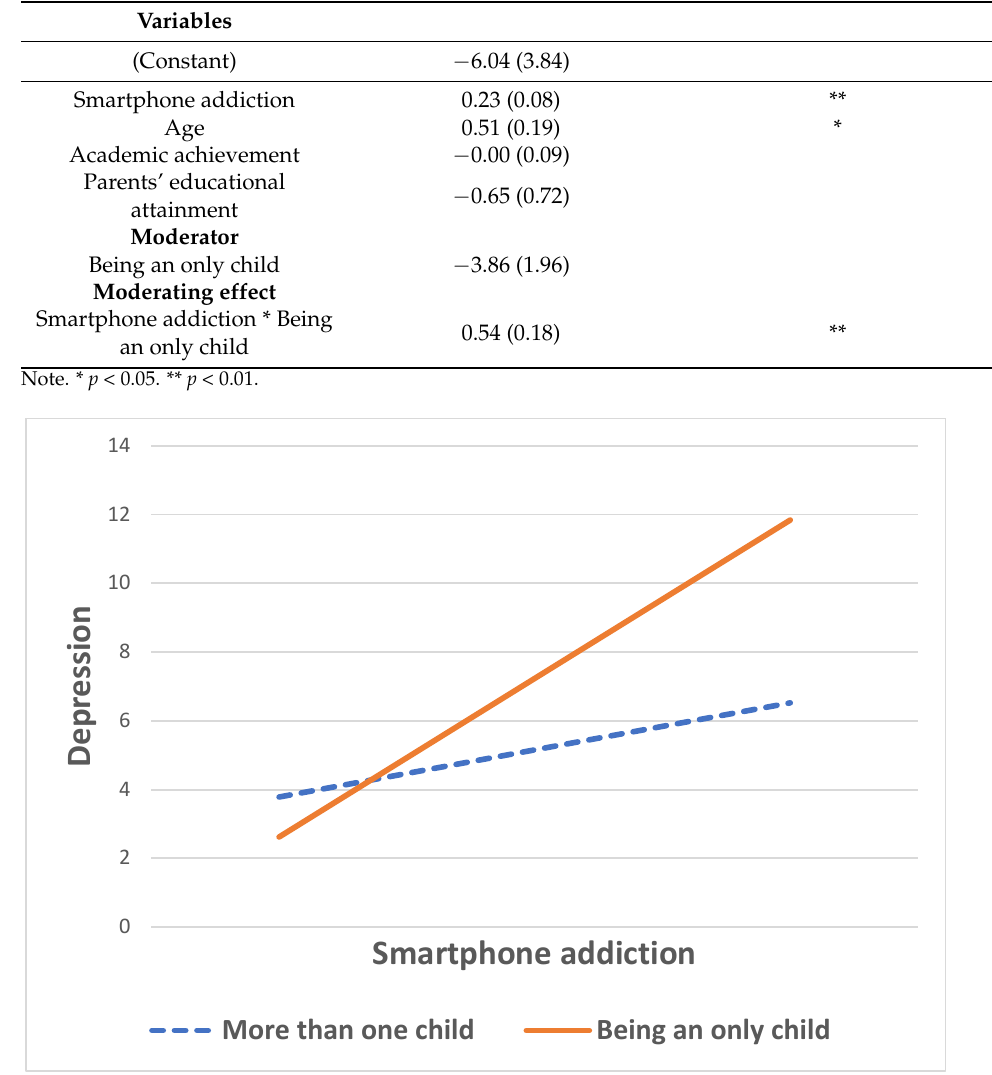
Figure 2. Moderating effect of being an only child on the relationship between smartphone addiction and depression among low-income boys.